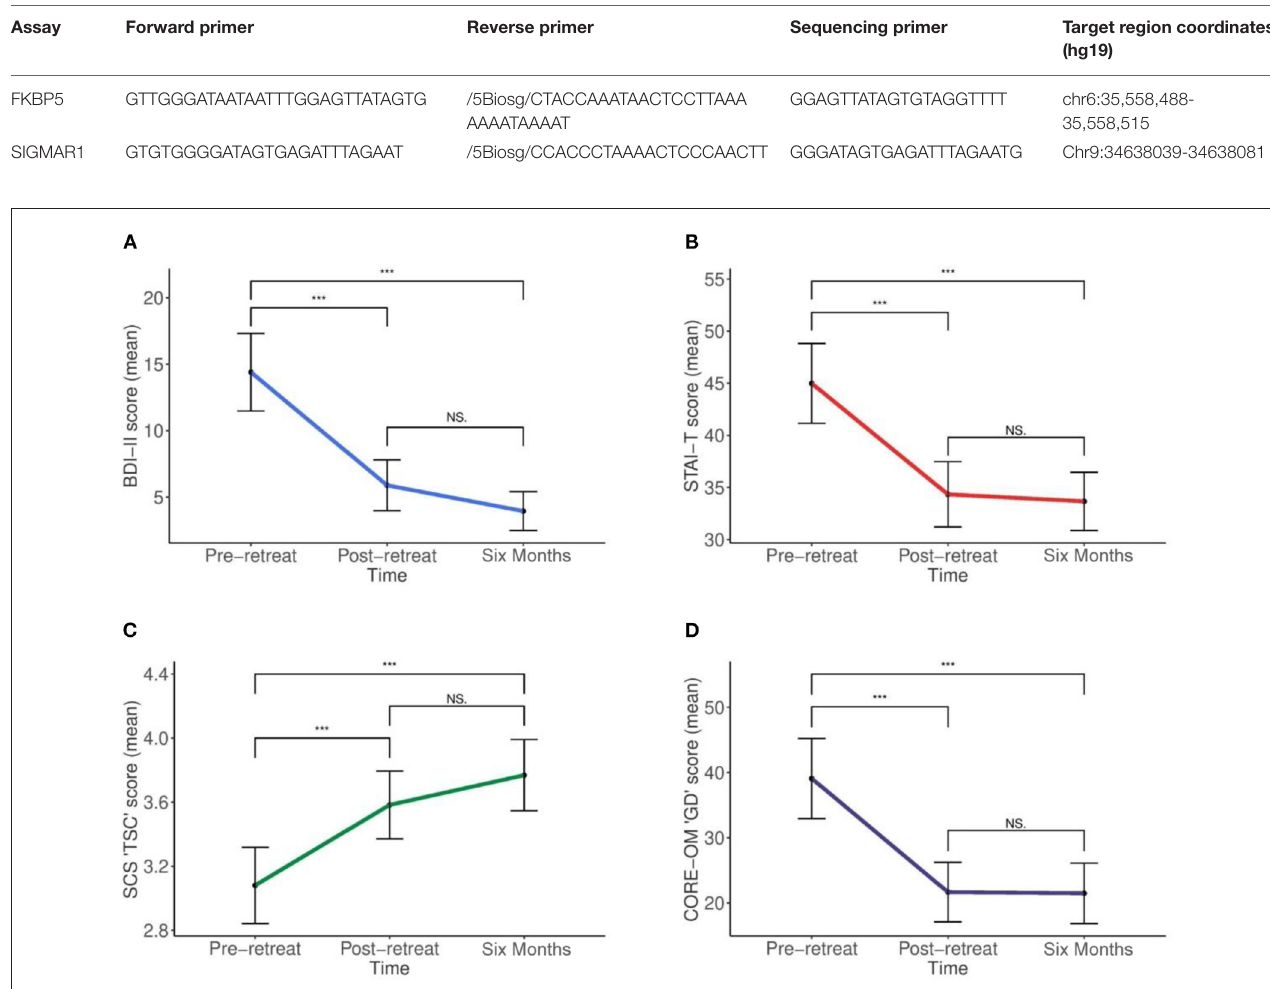
FIGURE 1 | Changes in outcome scores over time. (A) Beck Depression Inventory II (BDI-II). (B) State and Trait Anxiety Inventory (STAI)—Trait Anxiety Score. (C) Self Compassion Scale (SCS)—Changes in Total self-compassion (TSC) score. (D) Clinical Outcome Routine in Routine Evaluation (CORE-OM): changes in mean CORE-OM Global Distress (GD) score [NS, non-significant ( P > 0.05), *** p ≤